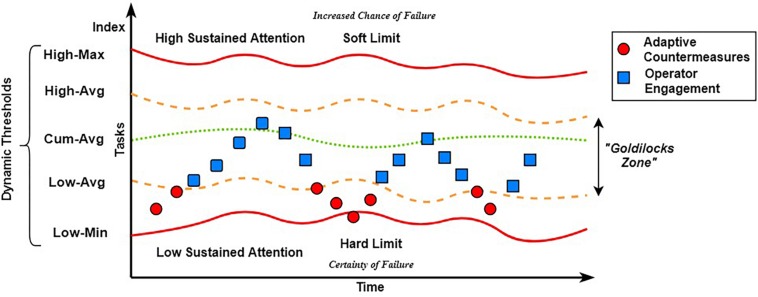
Visualized model of adaptivity, utilizing engagement index values and adaptive thresholds.